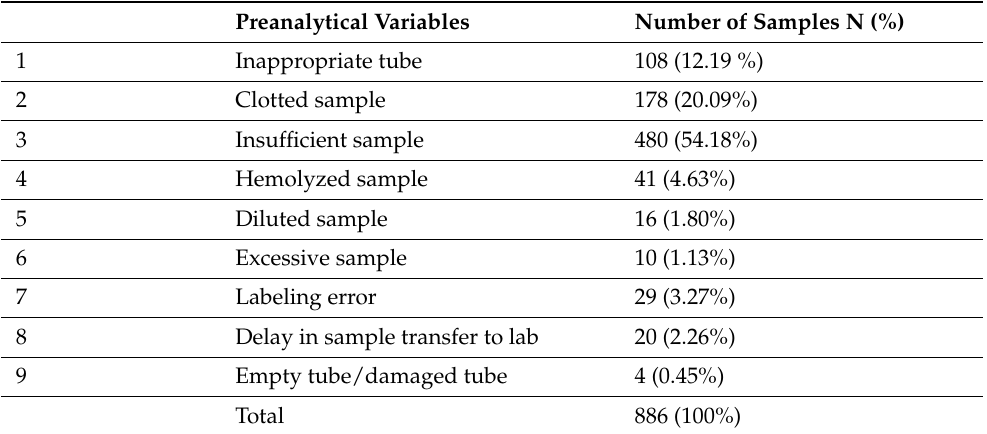
Table 1. Frequency distribution of rejected samples across preanalytical